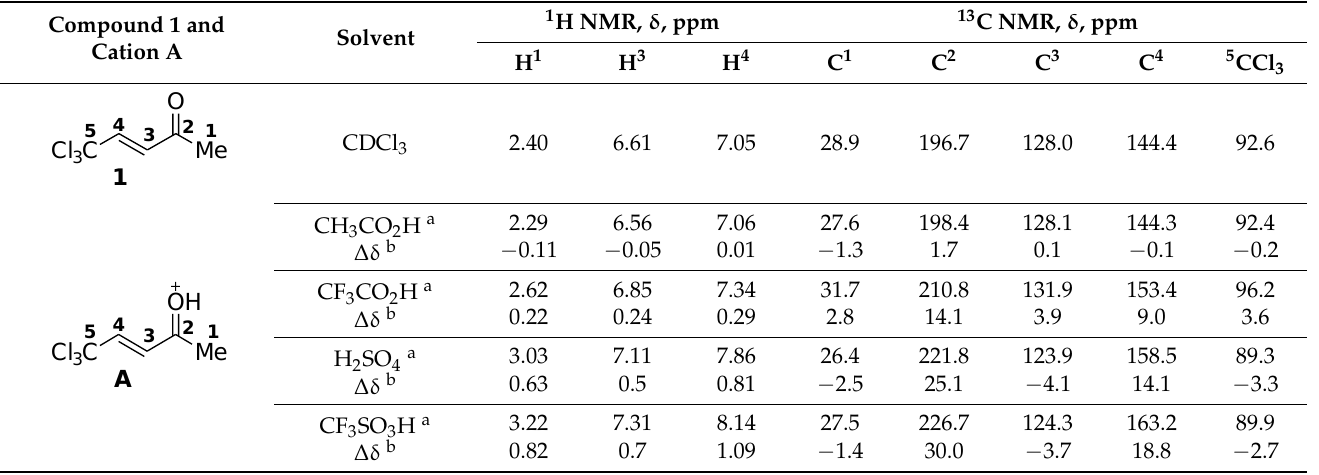
Table 1. 1 H and 13 C NMR data of CCl 3 -enone 1 (in CDCl 3 ) and its O-protonated form A (in Brønsted acids). Compound 1 and Compound 1